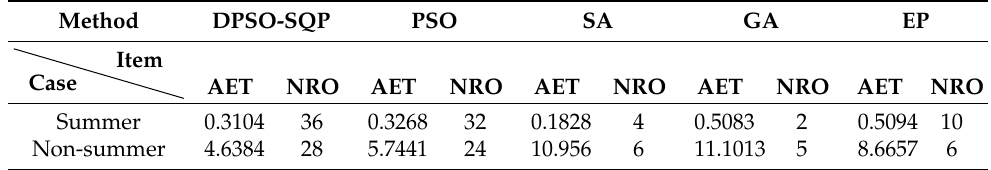
Table 7. The performance tests of various